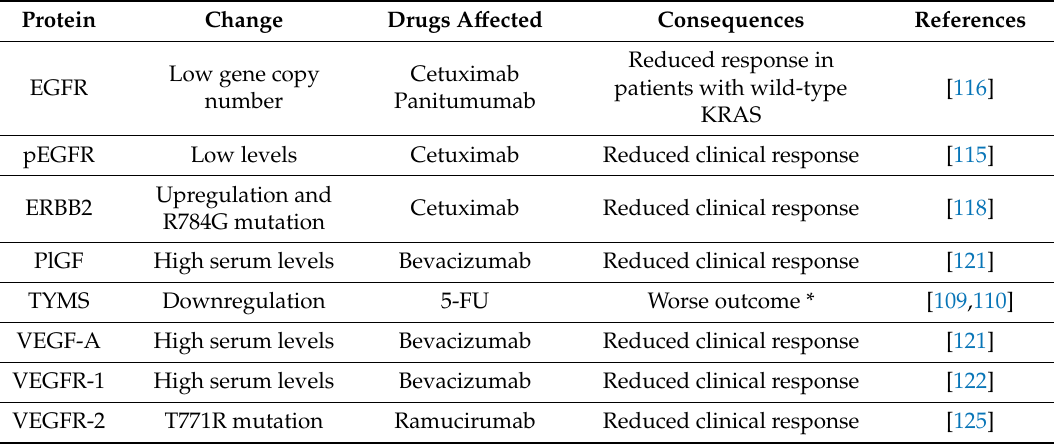
Table 3. Mechanisms of chemoresistance type 3 (MOC-3) in colorectal cancer. Protein Change Drugs A ff ected Consequences Reduced response in Low gene copy Cetuximab patients with wild-type [116] EGFR number Panitumumab KRAS pEGFR Low levels Cetuximab Reduced clinical response [115] Upregulation and Cetuximab Reduced clinical response [118] ERBB2 Bevacizumab Reduced clinical response [121] 5-FU Worse outcome * [109,110] Bevacizumab Reduced clinical response [121] High serum levels Bevacizumab Reduced clinical response [122] VEGFR-2 T771R mutation Ramucirumab Reduced clinical response [125] 5-FU: 5-fluorouracil; *: contradictory